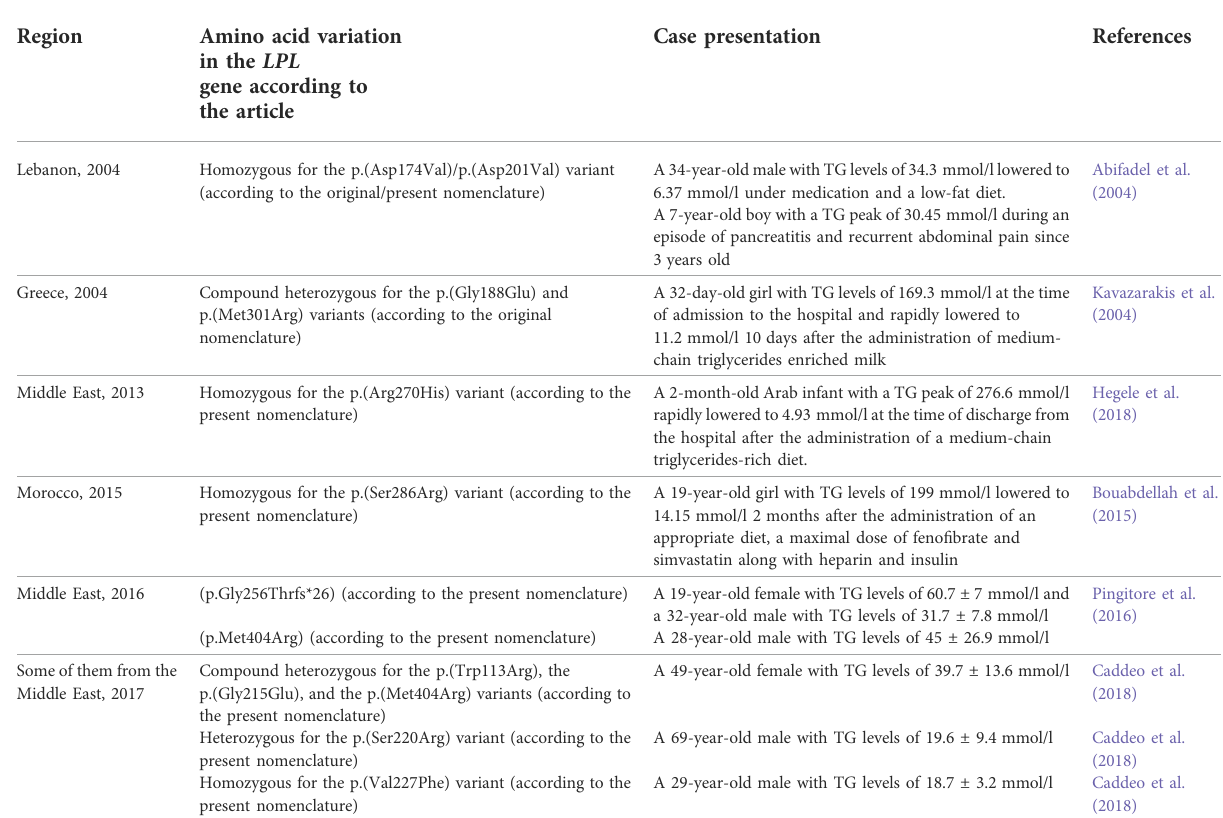
TABLE 2 Summary of the described variations in the LPL gene in the Middle East and the Mediterranean